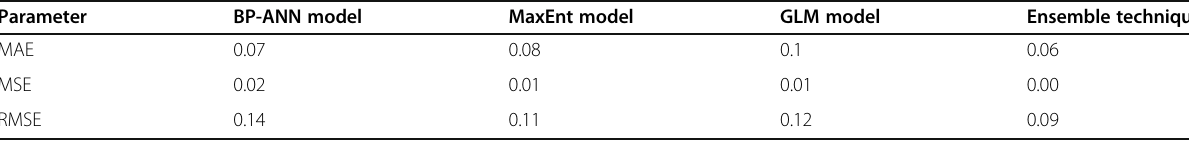
The results of landscape metrics in different classes of landform and the relationship between species habitat Table 6. The highest (1,474,162.19 ha) and lowest (53.28